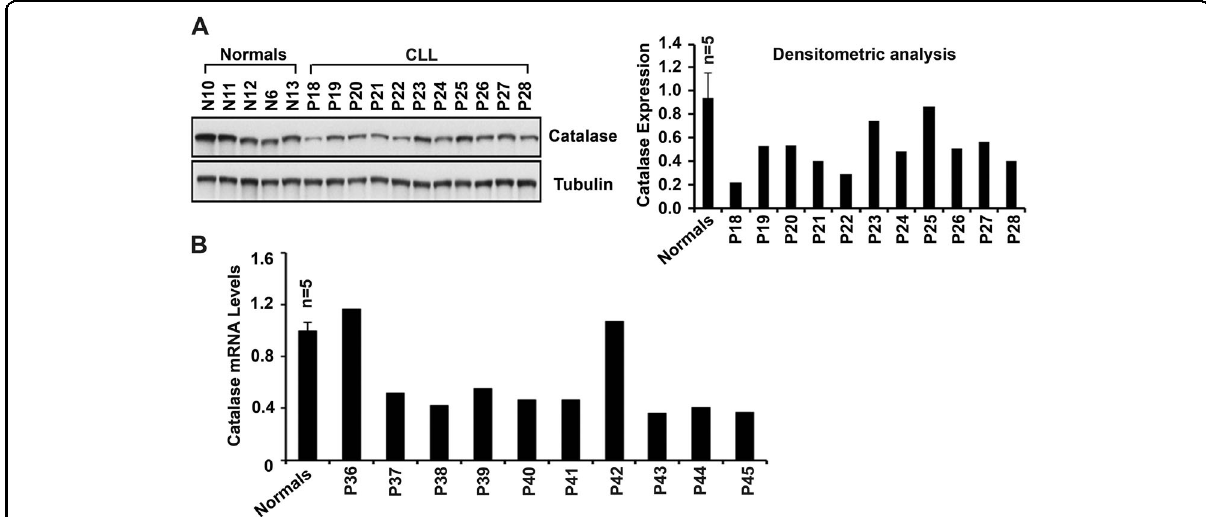
Fig. 2 CLL cells express reduced levels of catalase. A Puri fi ed normal B-cells from healthy individuals ( n = 5; N6, N10 – N13) or CLL cells from CLL patients ( n = 11; P18 – P28) were analyzed for the expression of catalase in western blot using a speci fi c antibody. β -tubulin was used as loading control. Densitometric analysis of the blot was also performed to determine relative levels of catalase protein (right panel) with respect to the mean normalized value of catalase levels in normal B-cells. B Total RNA from puri fi ed normal B-cells ( n = 5; N6, N10 – N13) or CLL cells puri fi ed from the indicated CLL patients ( n = 10; P36 – P45) was reverse transcribed and quantitative PCR for catalase was performed in triplicate using the SYBR Green PCR core Master Mix. GAPDH was used for cDNA normalization. Relative transcript levels of catalase was calculated using the comparative Ct